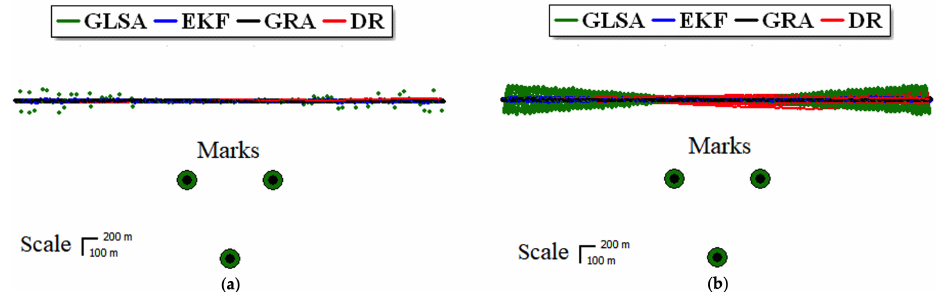
Figure 15. Triangle alignment of beacons and SV positions estimated relative to them during: ( a ) a single crossing, ( b ) 100 crossings.